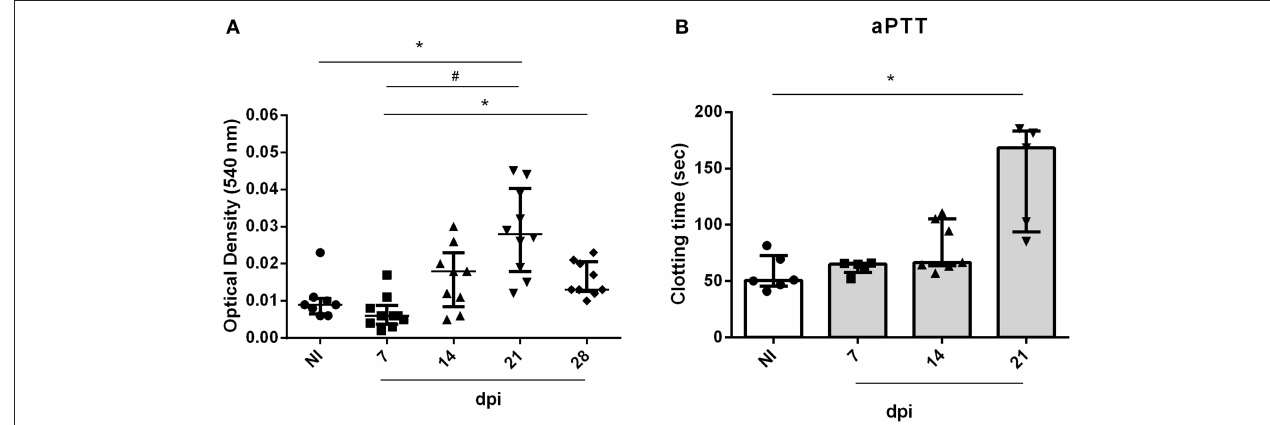
FIGURE 3 | Bleeding from the tail of BALB/c mice and ex vivo PT and aPTT measurements during oral infection. Male BALB/c mice were infected with 5 × 10 4 insect-derived metacyclic forms of T. cruzi (Tulahuén strain) within oral cavity. (A) Bleeding was caused by a tail transection in NI, 7, 14, and 21 dpi OI mice. Absorbance at 540nm (hemoglobin concentration) was used to estimate blood loss. (B) NI or OI plasma samples were obtained by cardiac puncture followed by addition of aPTT or PT reagent as described in the “Methods” section. Clotting time was estimated using a coagulometer. (A,B) Values represent the median with interquartile range for each group/day post-infection and are representative of two independent experiments. Results were analyzed using the Kruskal-Wallis with Dunn’s multiple comparisons test (*0.0001 < p < 0.05, # p < 0.0001).